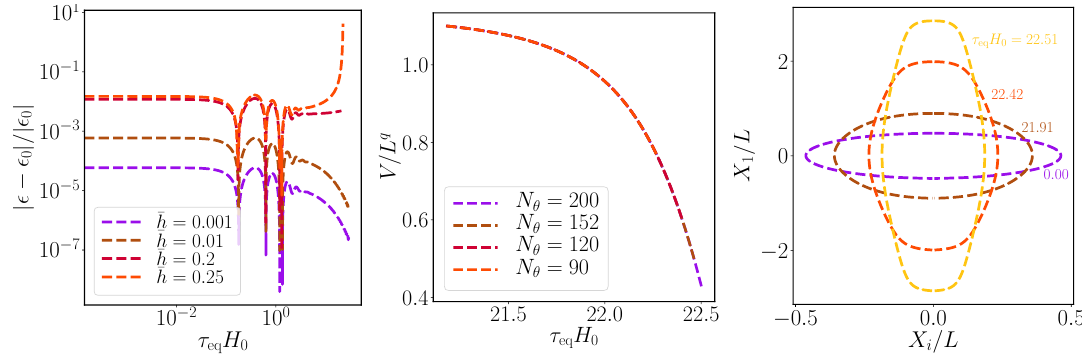
Figure 5 . A sample solution on the small volume branch with p = q = 4 , Λ D = 1 , H 0 /M 4 = 0 . 0077 and an ‘ = 2 perturbation. Left: the relative difference between the aspect ratio of the sample solution and the background Freund-Rubin solution for successively larger perturbations. Middle: the q -dimensional volume of the internal space for successively higher resolutions for initial data with ( ‘, ¯ h ) = (2 , 0 . 3) . Right: several snapshots of the embedding of internal space for initial data with ( ‘, ¯ h ) = (2 , 0 . 3)